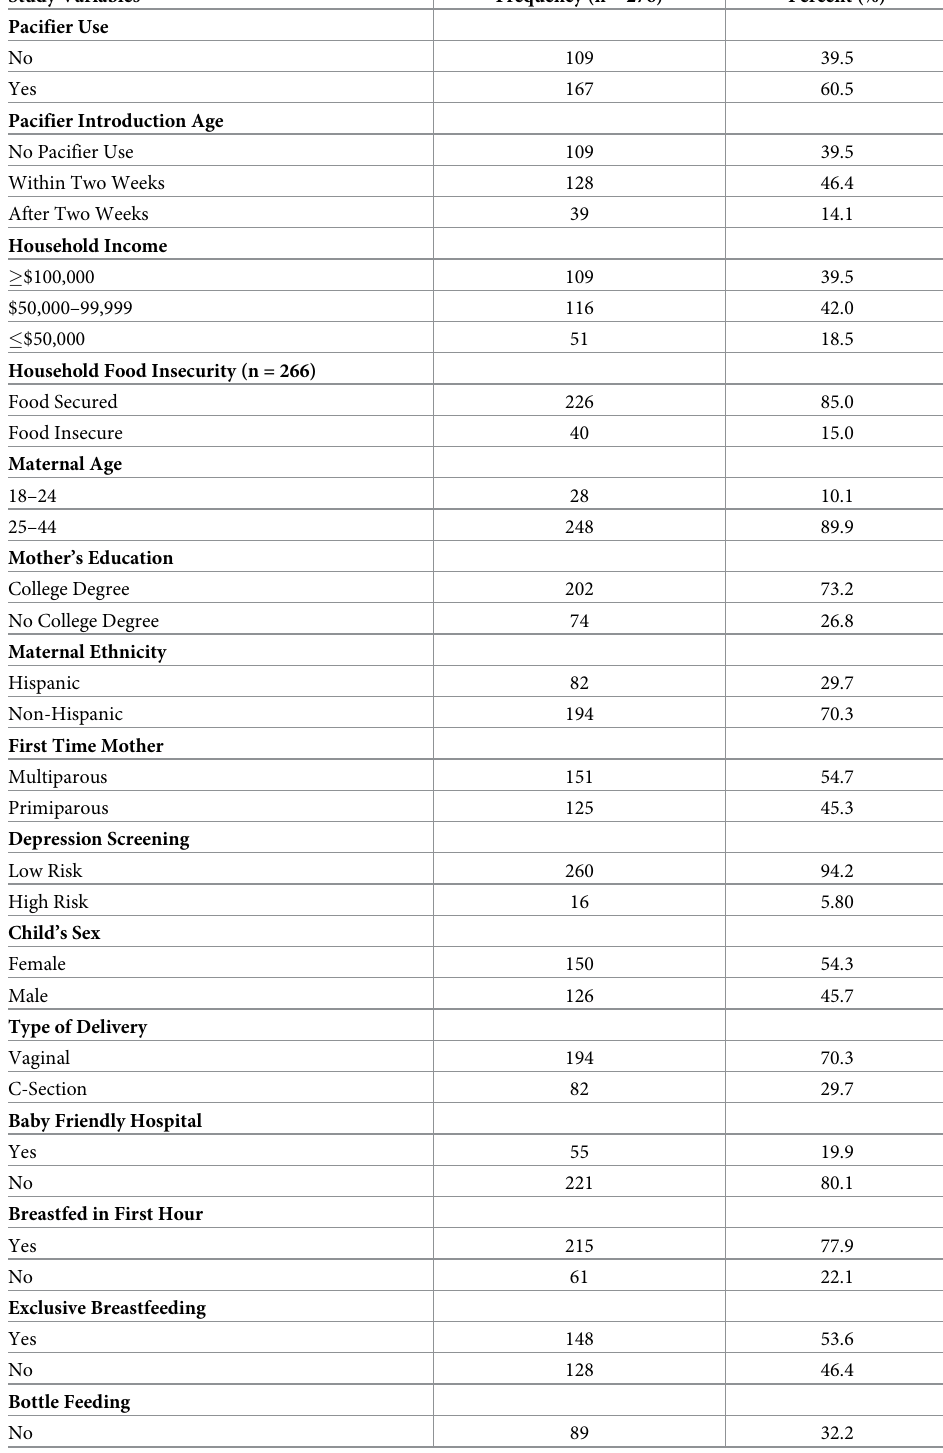
Table 1. Descriptive analysis of pacifier use, household, maternal, infant, and health care characteristics, and infant feeding and sleeping practices,